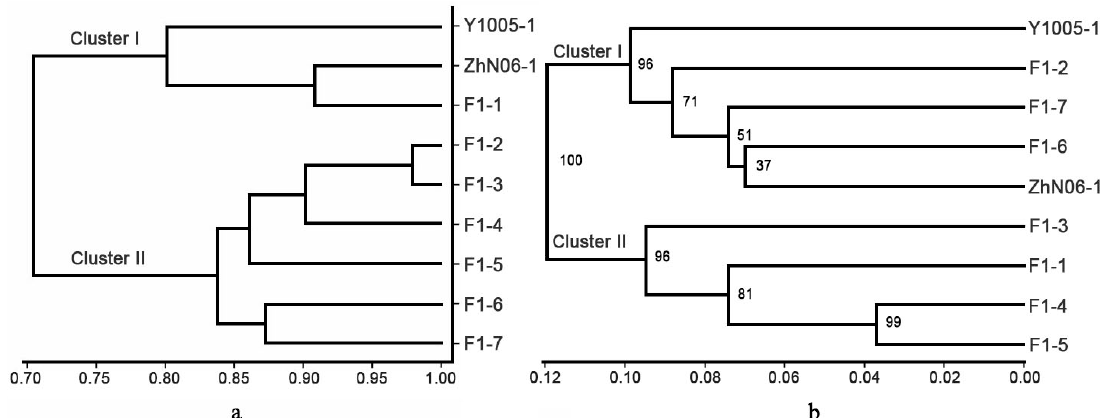
Figure 4. Dendrograms of the parents and F 1 generations of E. sibiricus using UPGMA from phenotypic data ( a ) and marker-based data ( b ). The numbers marked on the branches ( b ) are bootstrap values (%) out of 1000 bootstrapping .